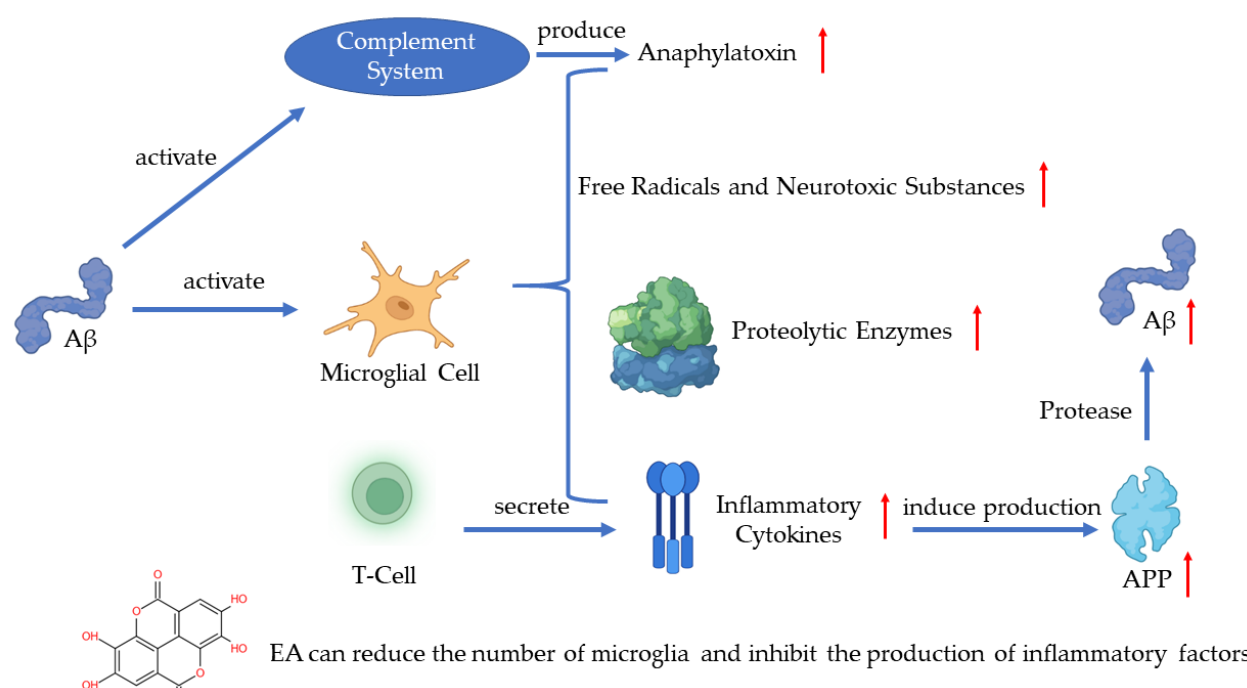
Figure 4. Pathogenesis of AD and the role of EA.